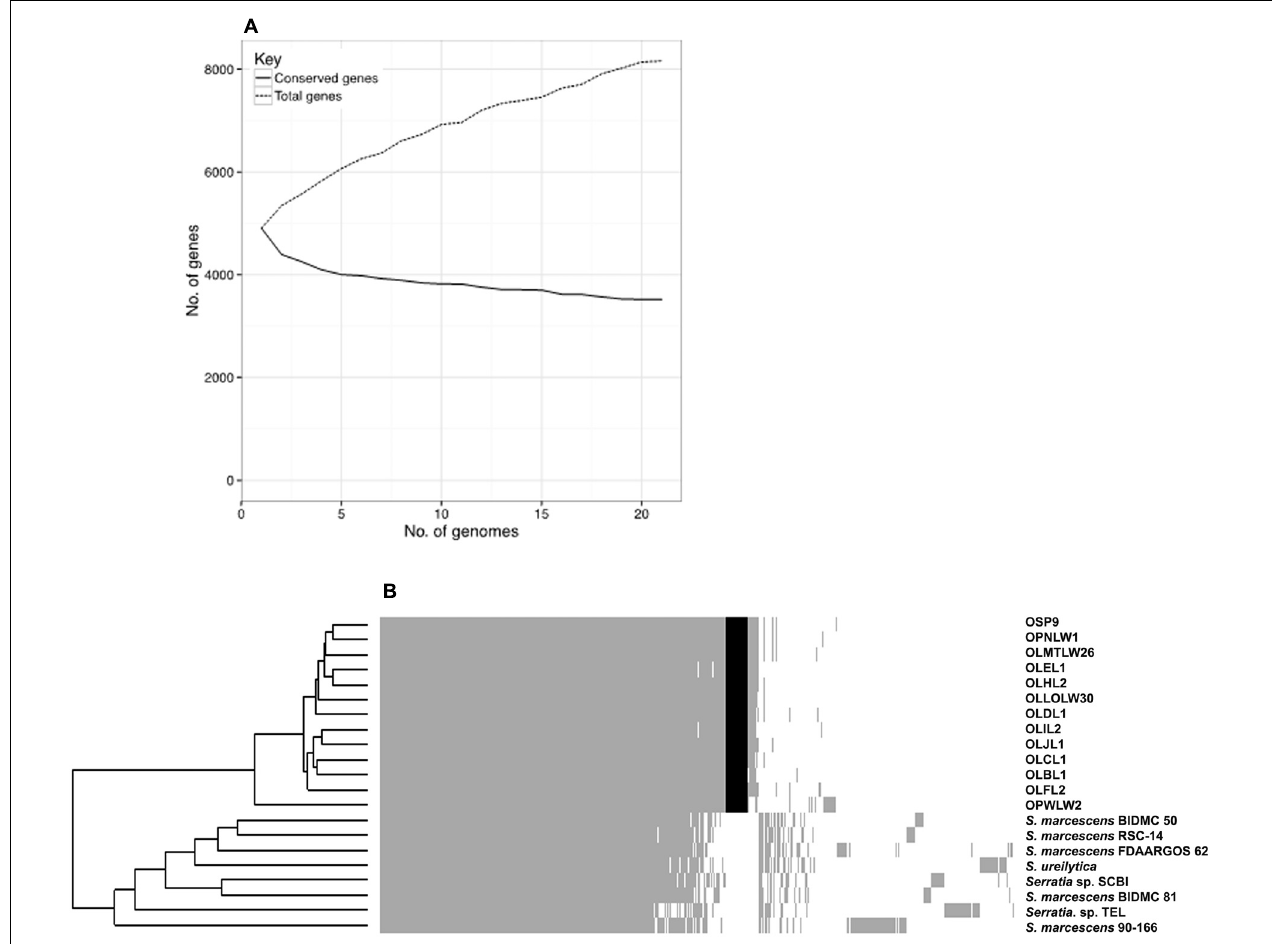
FIGURE 5 | Pangenome analysis of strains within the Serratia SCBI complex. Overview of the complete pangenome displays stabilising conserved gene content while total gene content continues to augment, suggestive of an open pangenome for the SCBI complex (A) . The pangenome gene presence/absence metrics displayed as a heatmap highlights the diversity within the SCBI complex. Grey shading confirms gene presence, white space confirms gene absence, and black shading highlights all Orius -associated genes absent from all other members of the SCBI complex (B)